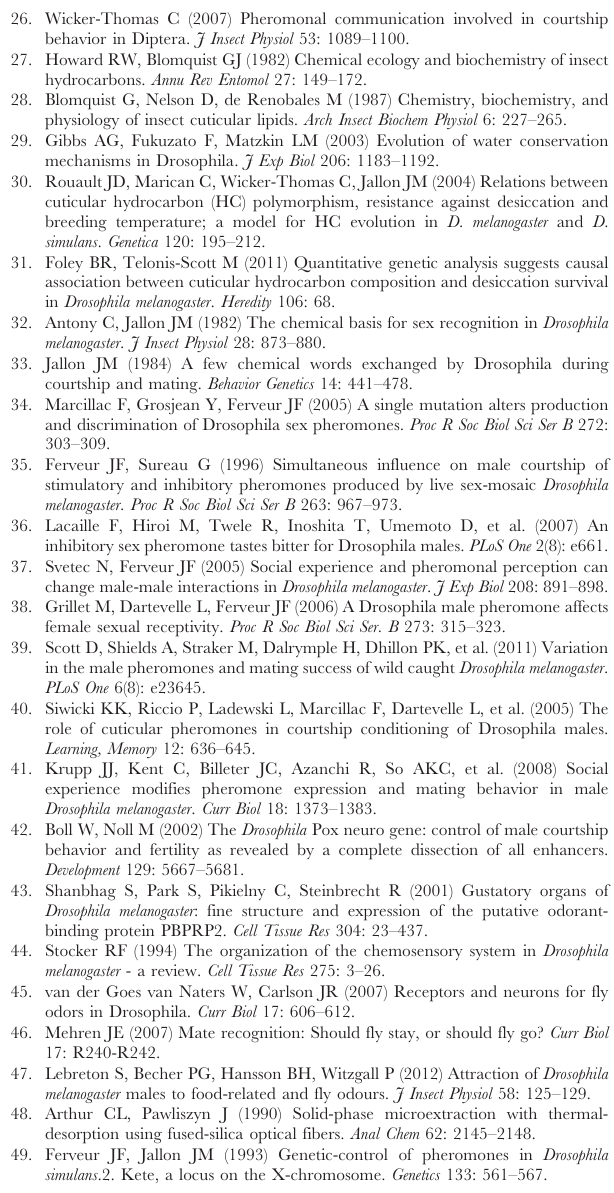
Table S2 Results of the two-way ANOVA using the Cox- Box transformed CH proportions of all the cuticular compounds as quantitative variables and the two social changes (early, mature), in male (A) and female (B). HSD: letters indicate significant differences (Tukey’s HSD test, p = 0.05). For compound names, see Table1. ( n = 5 6 10 or 20